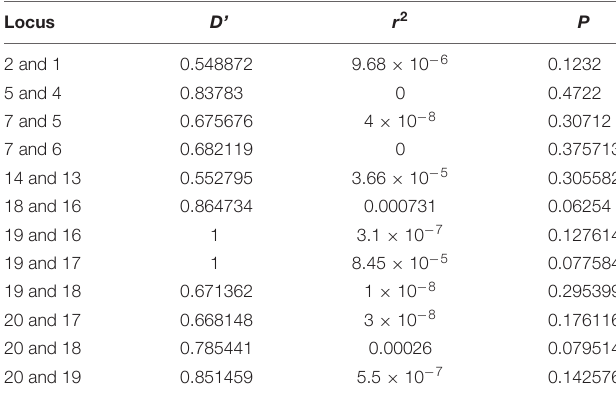
TABLE 4 | The relationship between D’ , as well as r 2 and P -values among